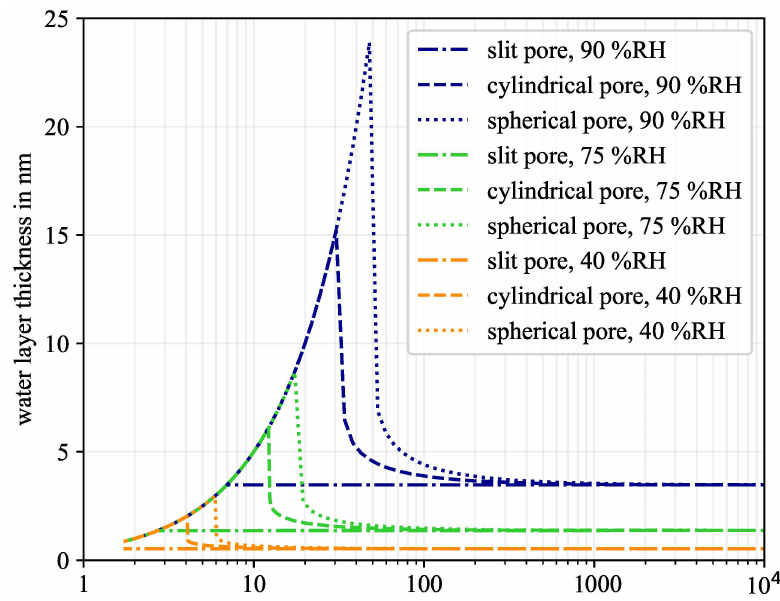
Figure 1. Predicted water layer thickness of different pore geometries due to